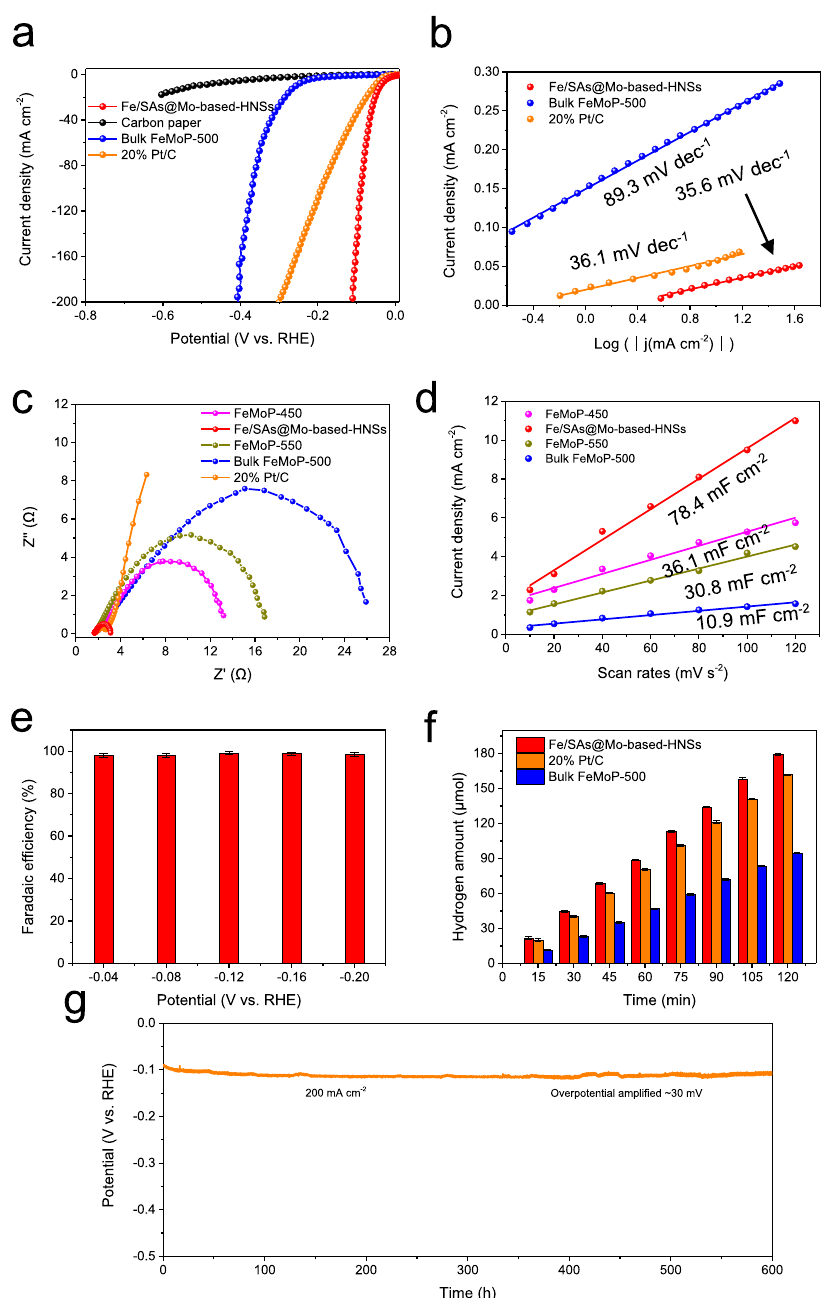
Fig. 4 | Electrocatalytic performance of Fe/SAs@Mo-based-HNSs in the HER in 1.0M KOH solution. a Polarisation curves at a scan rate of 5mVs − 1 with potential error (iR) correction; b corresponding Tafel plots; c Electrochemical impedance spectroscopy (EIS) of the FeMoP-T samples and 20% Pt/C at an overpotential of 200mV; d calculated electrochemical double-layer capacitance for selected as-